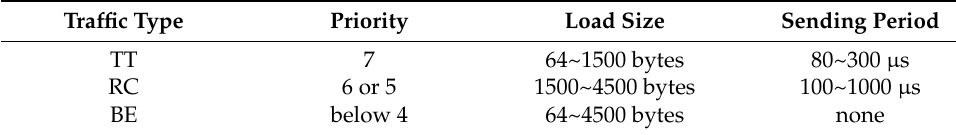
Table 2. The parameter setting of three types of traffic.